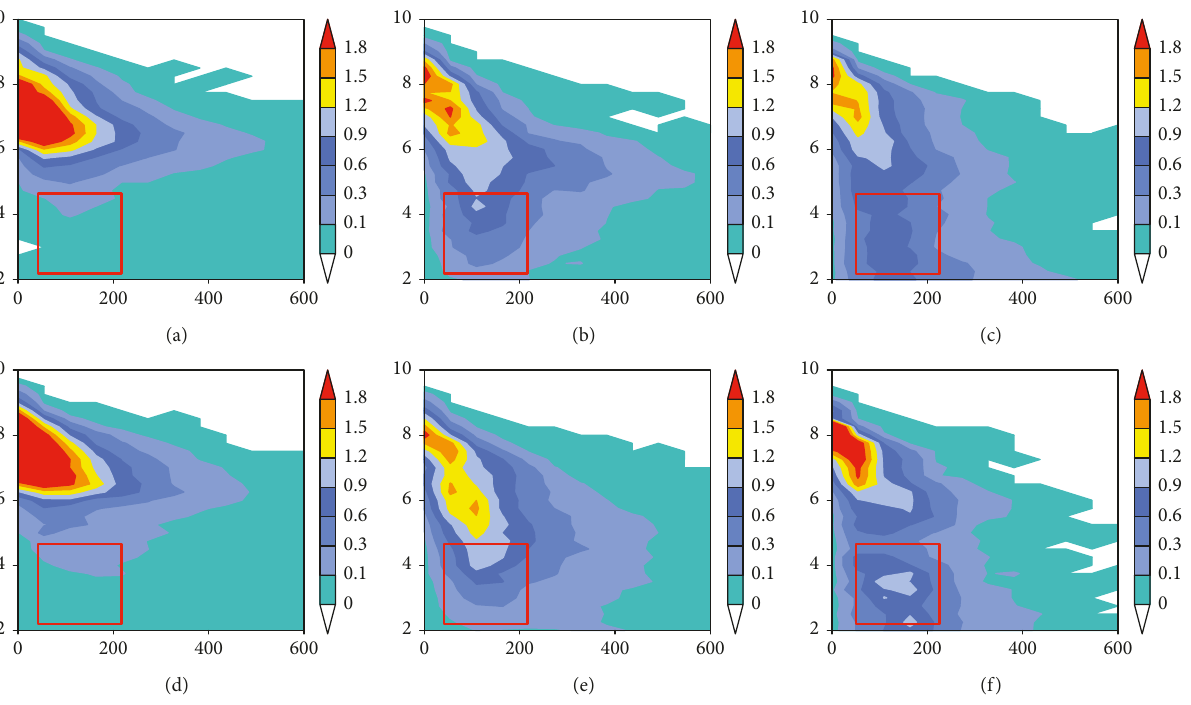
Figure 13: The vertical distribution of the number concentration of cloud droplets corresponding to different types of TPV category cloud clusters over each key region (same as above): (a) lwc_TP (IC); (b) lwc_ESTP (IC); (c) lwc_MYR (IC); (d) lwc_TP (ILC); (e) lwc_ESTP (ILC); (f) lwc_MYR